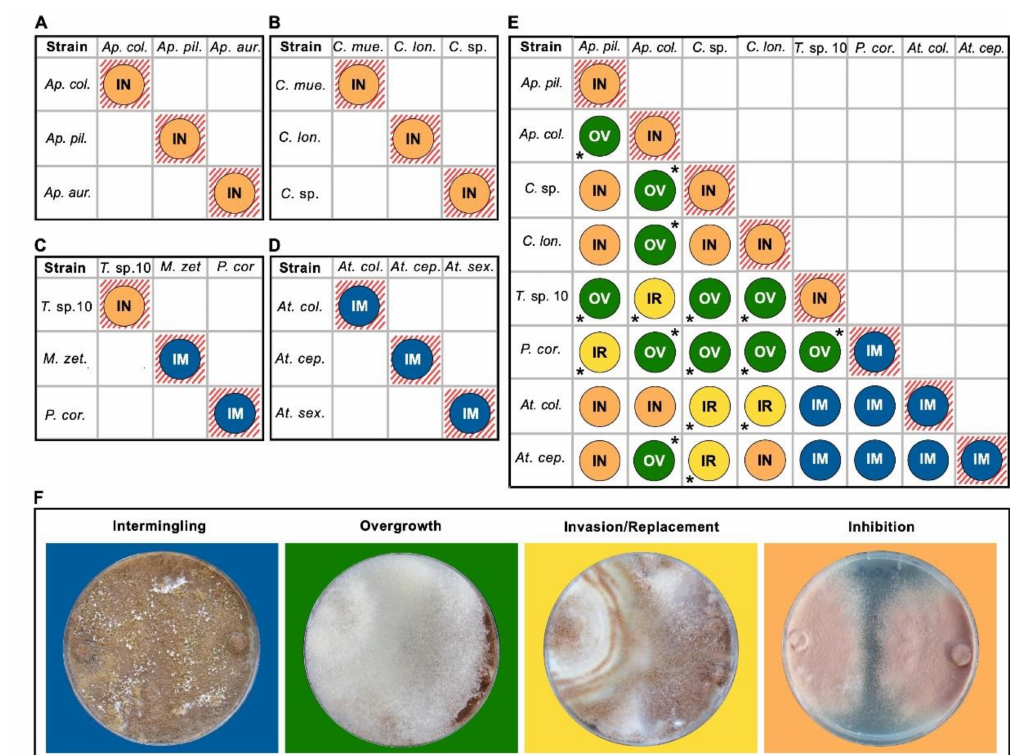
Figure 4. Outcomes of intra- and interclonal confrontation bioassays. The left, top quadrants ( A – D ) indicate outcomes of intraclonal interactions for 12 Escovopsis strains isolated from colonies of the lower attine ant genera, Apterostigma ( A ) and Cyphomyrmex ( B ), and derived genera, including Trachymyrmex , Mycetomoellerius , and Paratrachymyrmex ( C ), and Atta ( D ). The right, top quadrant ( E ), indicates results of factorial interactions among eight Escovopsis isolated from colonies of eight attine ant species. Boxes with lines are intraclonal interactions, and those without lines are interclonal interactions. The asterisk positioned on the bottom left of the interaction type symbol indicates that the strain that grows in excess or replaces it is the one indicated in the row, while an asterisk positioned on the top right of the interaction type indicates that the strain that grows in excess or replaces it is the one indicated in the column. ( F ) Representative interaction outcomes. Intermingling occurs when both fungi grow into one another without any inhibition zone. Overgrowth occurs when one strain grows towards and completely covers the other. Invasion/replacement occurs when one strain grows towards the other and then begins to consume it, or in some cases, completely replaces it. Inhibition occurs when strains approach each other but leave a demarcation line between them. Abbreviations and full names: Ap. col , Apterostigma collare ; Ap. pil , Ap . pilosum ; Ap . aur